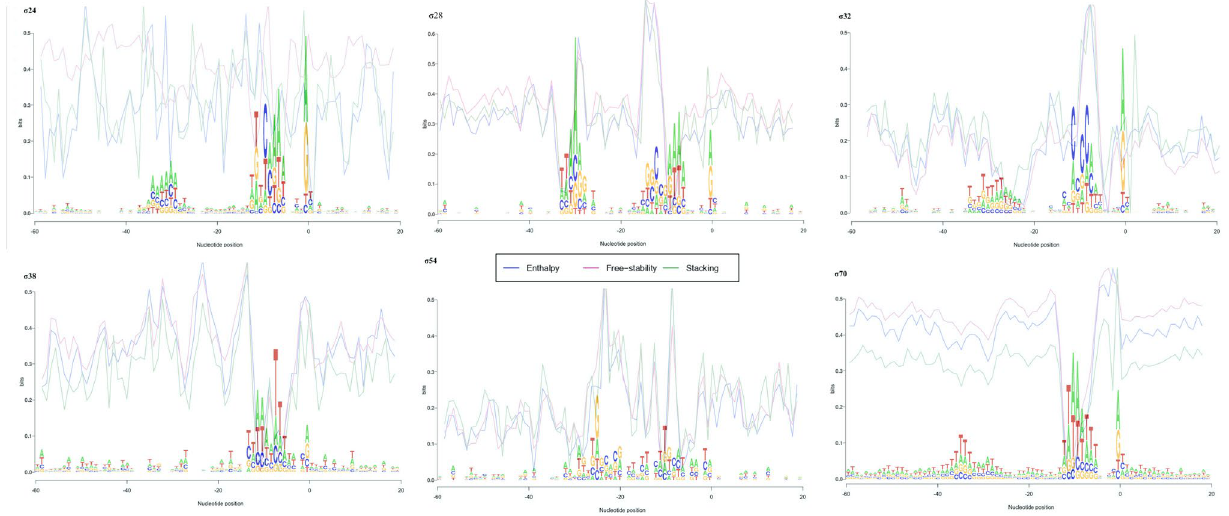
Fig. 2 Average values of enthalpy, free-stability, and base-pair stacking along the 80 nucleotides overlayed with the sequence logo profile of each